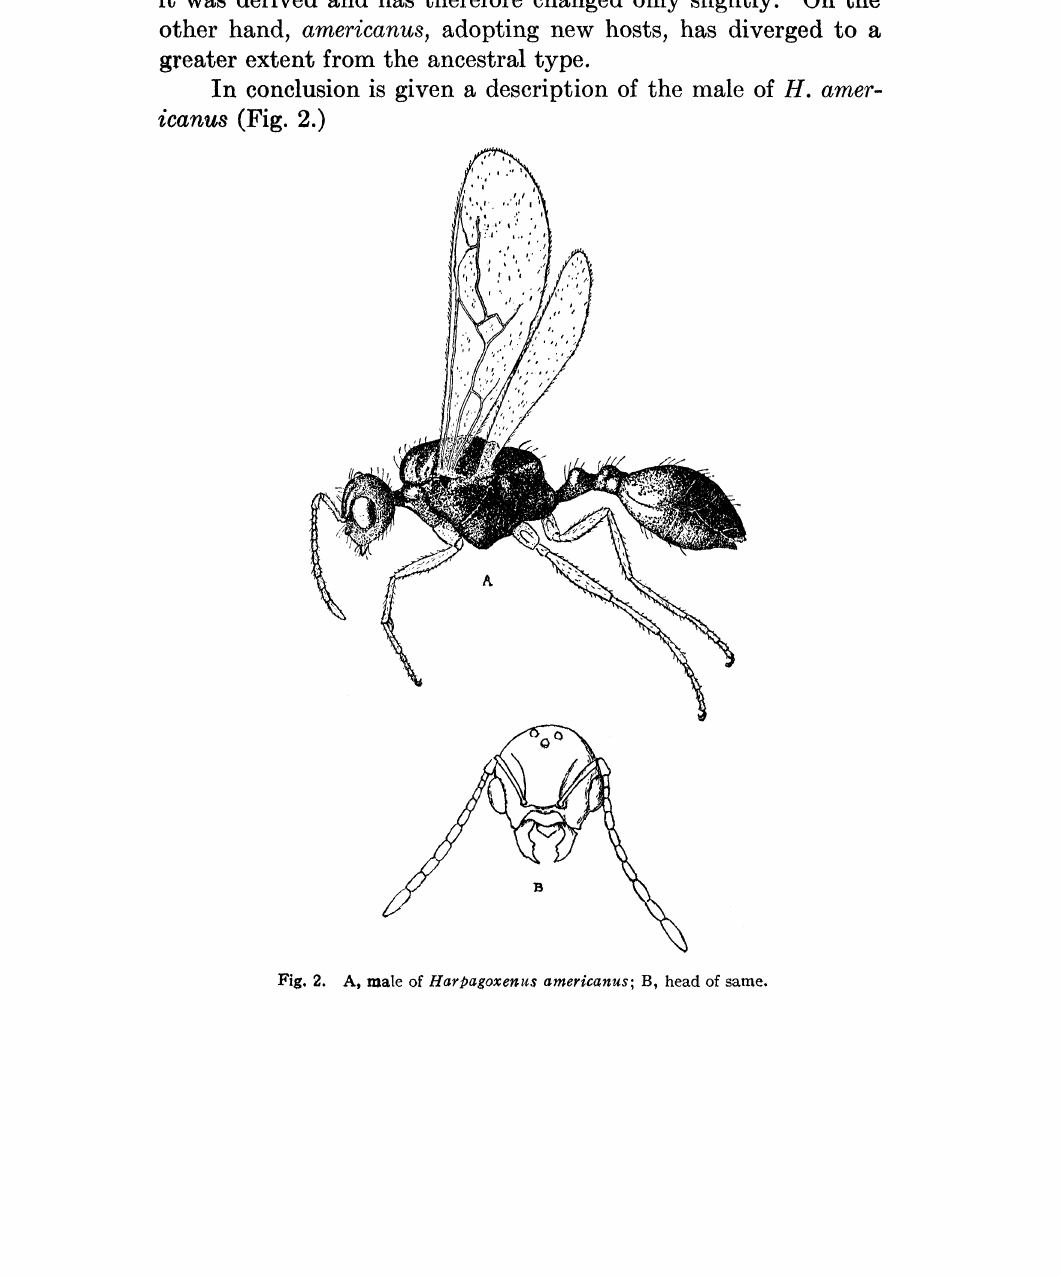
Fig. 2. A, male of Harpagoxenus americanus; B, head of